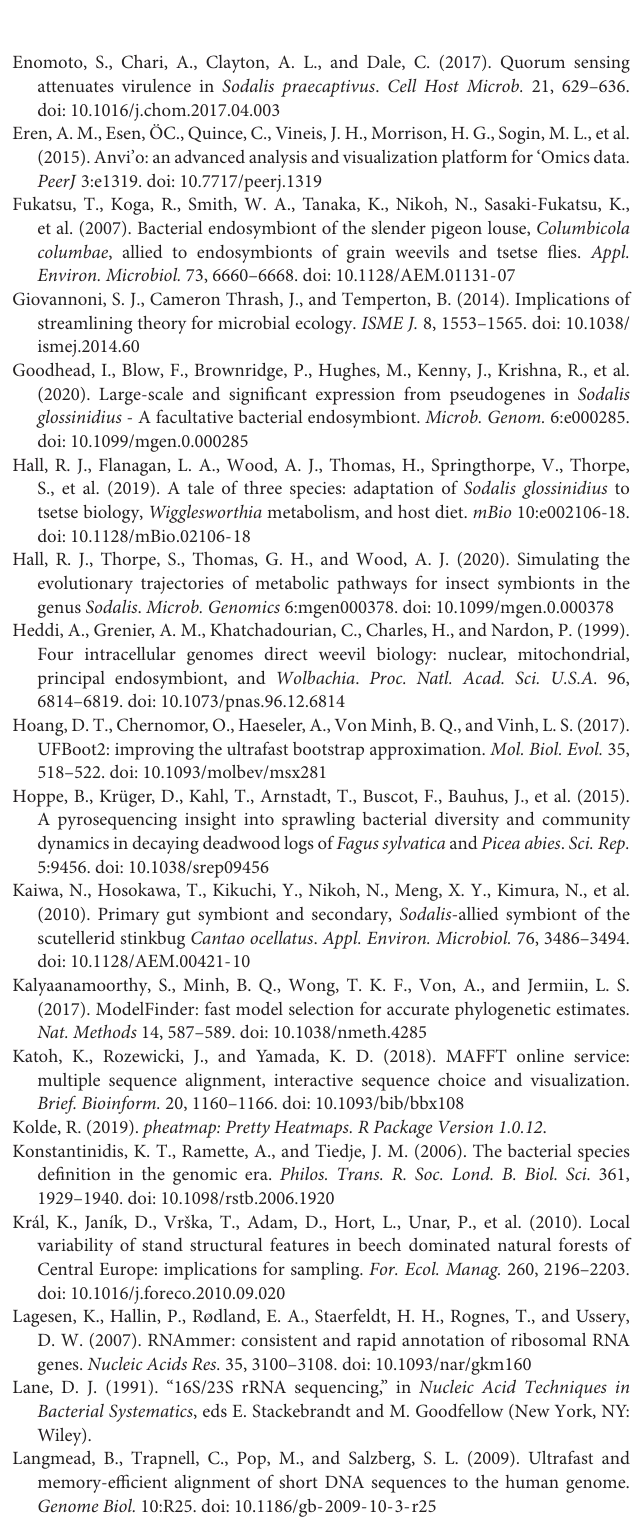
Supplementary Table 5 | Relative abundances of a Sodalis OTU with 99.6% similarity to S. ligni among deadwood of 13 tree species after 6 years of decomposition from the study Moll et al. (2018). Data represent means and standard